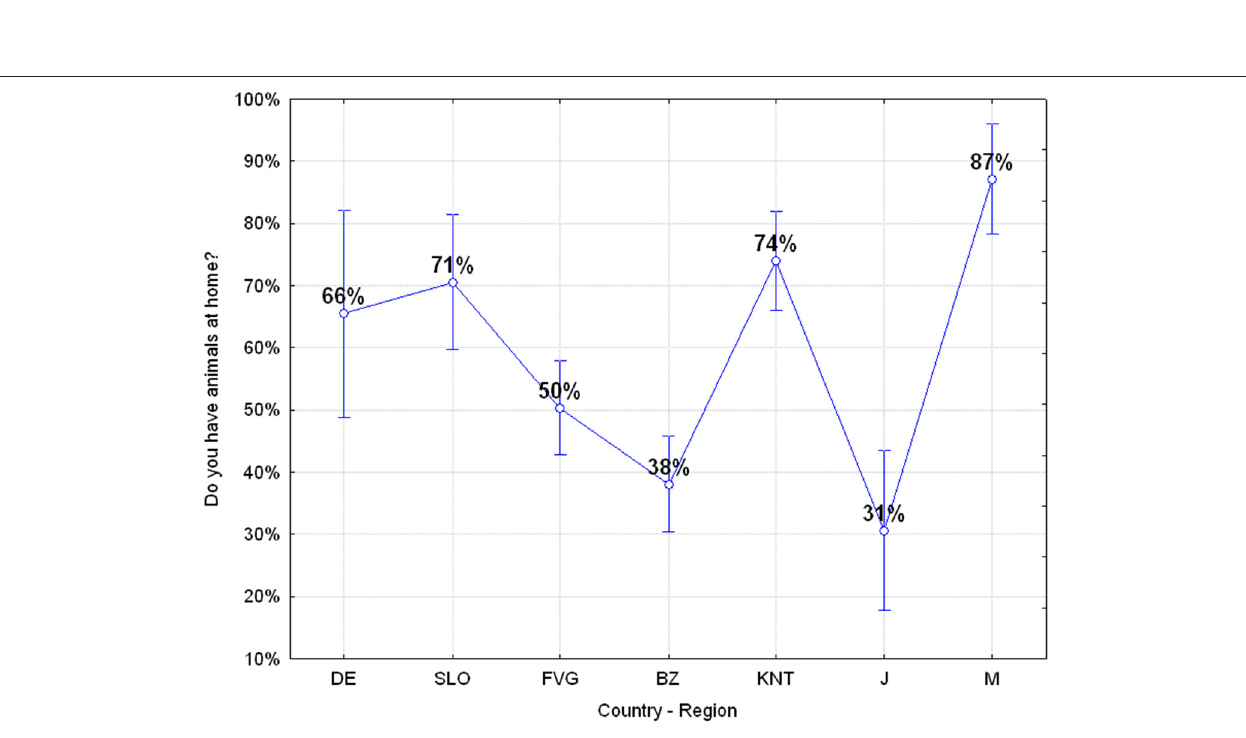
Frontiers in Public Health |